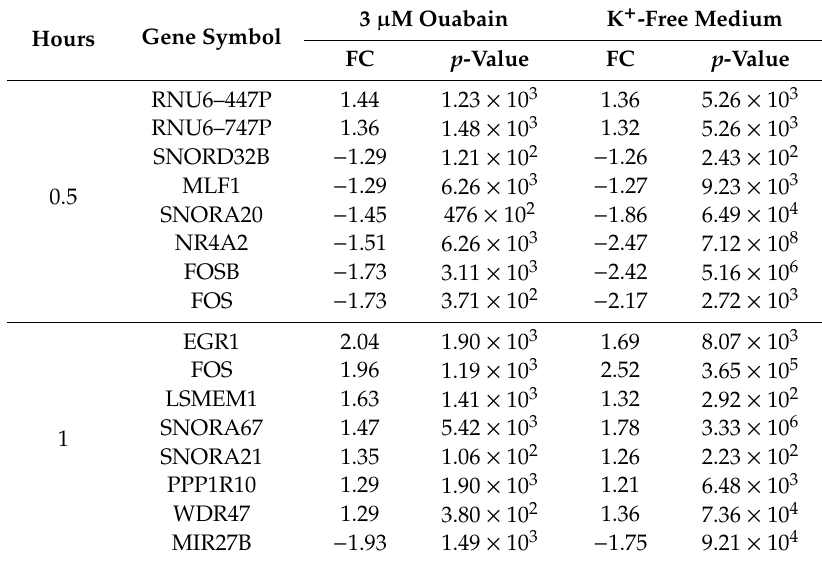
Table 2. Common di ff erentially expressed genes triggered by Na,K-ATPase inhibition by 3 µ M ouabain or K + -free medium in 0.5 and 1